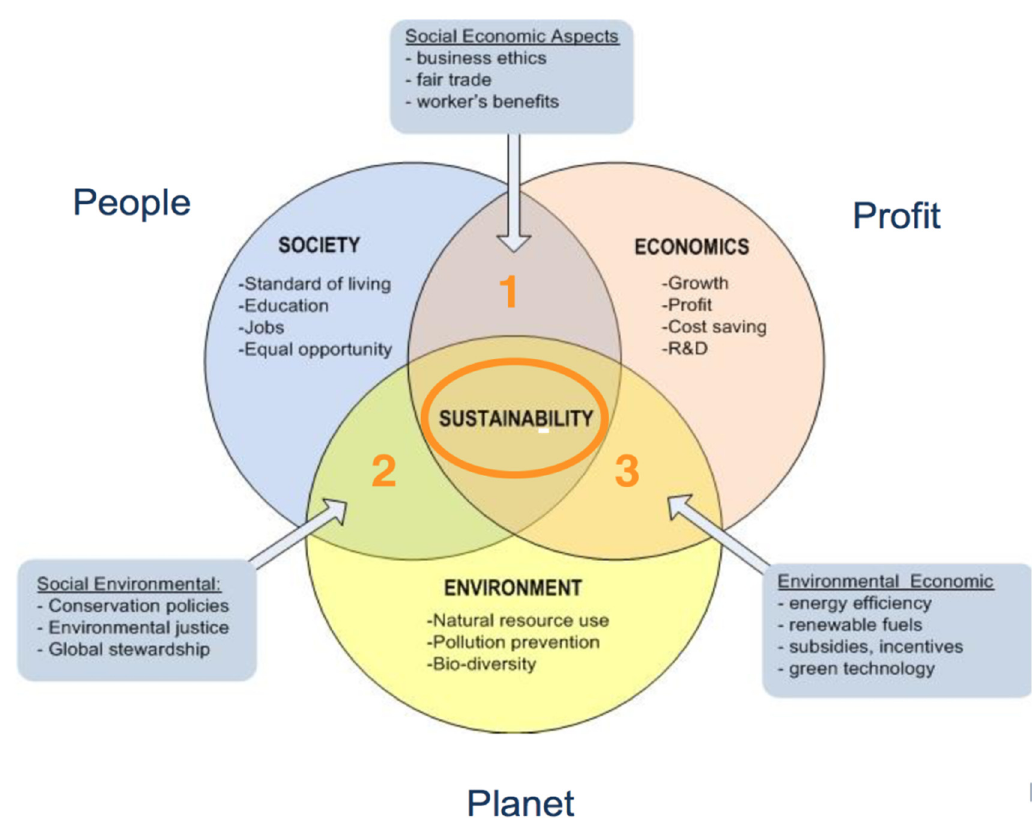
Figure 1. Key Elements of Sustainable Development. Source: Freimann et al. [35].